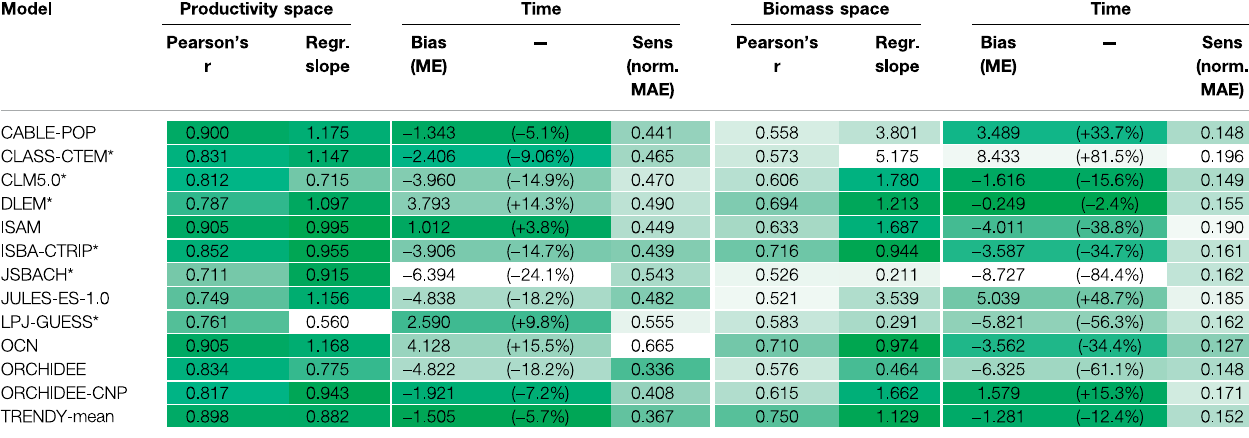
TABLE1| CorrespondencebetweenmodelsimulationsandsatelliteretrievedGPPandAGCfromMODISPML-v2andL-VODrespectively.WherePearson ’ srindicatesthe weighted Pearson ’ s r, slope is the slope of the linear model fi tted to the pairwise pixel comparison with weighted total least squares regression, bias in time is the mean error of the annually aggregated values (percentages in brackets show the relative error), and the sensitivity to interannual variability is quanti fi ed by the mean-normalised mean absolute error. Shading indicates the relative performance of each model, with darker shading indicating better correspondence. Regression slopes were shaded by their log 10 absolute value. * indicates models including explicit representation of fi re.